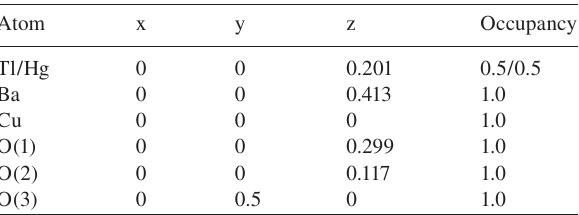
Table 3 Structural parameters used for image calculation of CuO . HgTlBa 2 6